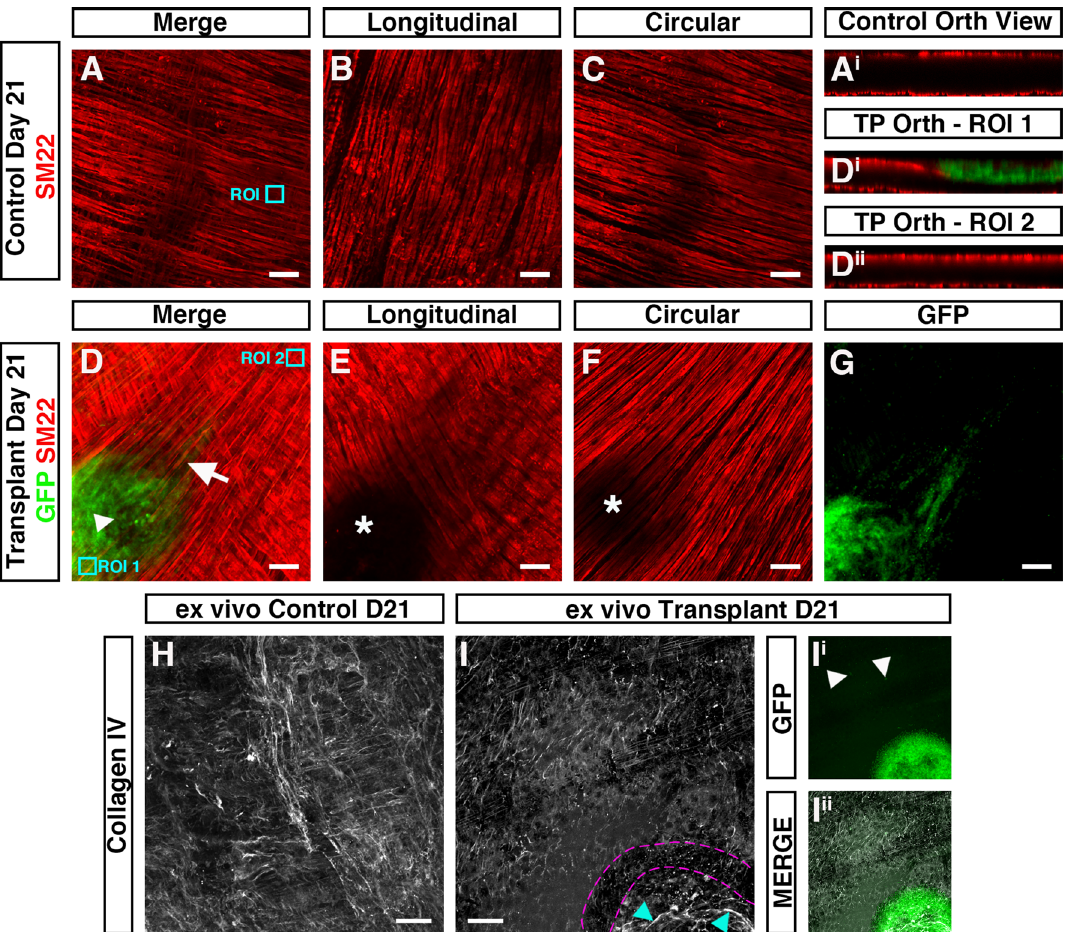
Figure 6. Donor cell integration induces tissue remodeling after ex vivo transplantation. ( A ) Representative confocal z-stack image of SM22 + ( red ) smooth muscle within control (non-transplanted) C57BL/6J colonic tissue at day-21. ( A i ) Orthogonal view taken from the region of interest ( ROI, cyan box) in A showing SM22 + smooth muscle in two uninterrupted layers. ( B , C ) Representative images of individual z-stacks at the longitudinal ( B ) and circular ( C ) muscle layers. ( D ) Representative confocal z-stack image of donor GFP + ( green ) and SM22 + ( red ) smooth muscle 21-days after ex vivo transplantation. ( D i &D ii ) Orthogonal views taken from ROIs (cyan boxes) in ( D ) showing interruption of the longitudinal smooth muscle ( D i ) at the site of neurosphere engraftment. At sites away from the area of neurosphere engraftment SM22 + expression appears to demonstrate two uninterrupted smooth muscle layers ( D ii ). ( E , F ) Representative images of individual z-stacks at the longitudinal ( E ) and circular ( F ) muscle layers 21-days after ex vivo transplantation. ( G ) Representative image of individual z-stack, at the level of the circular muscle (taken from D ), showing migration of GFP + donor derived cells from the site of neurosphere engraftment 21-days after ex vivo transplantation. ( H ) Representative confocal z-stack image of Collagen IV ( grey ) in control (non-transplanted) C57BL/6J colonic tissue at day-21. ( I ) Representative confocal z-stack image of Collagen IV ( grey ) 21-days following ex vivo transplantation. Note the presence of Collagen IV expression at the site of neurosphere transplantation ( cyan arrows ) and apparent discontinuity of Collagen IV expression surrounding the presumptive neurosphere boundary ( magenta dashed lines ). ( I i , I ii ) Representative GFP channel ( I i ) and merged ( I ii ) confocal z-stack images showing GFP + donor cells at the site of transplantation and within the tunica muscularis (arrows) having migrated away from the engrafted